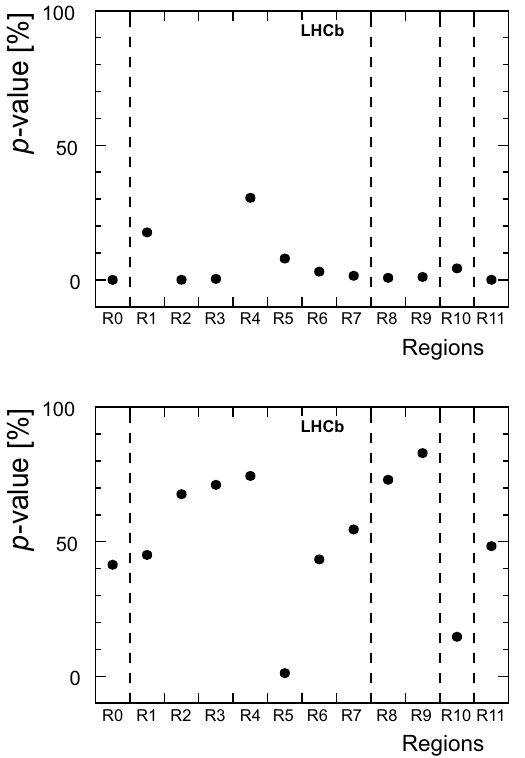
Fig. 8 (Top left) pulls, (μ T − μ T R )/Δ(μ T − μ T R ) , and (top right) the corresponding p -values; (bottom left) pull values of the test statistic T and (bottom right) the corresponding p -values in regions for signal Ξ + → pK − π + candidate decays obtained using the kNN method with c n k = 50 for combined data collected 2011 and 2012. The horizontal